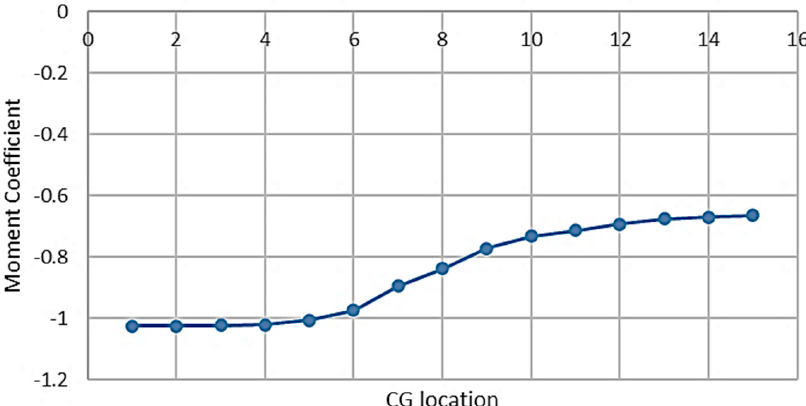
Figure 11. CG location vs moment coefficient.